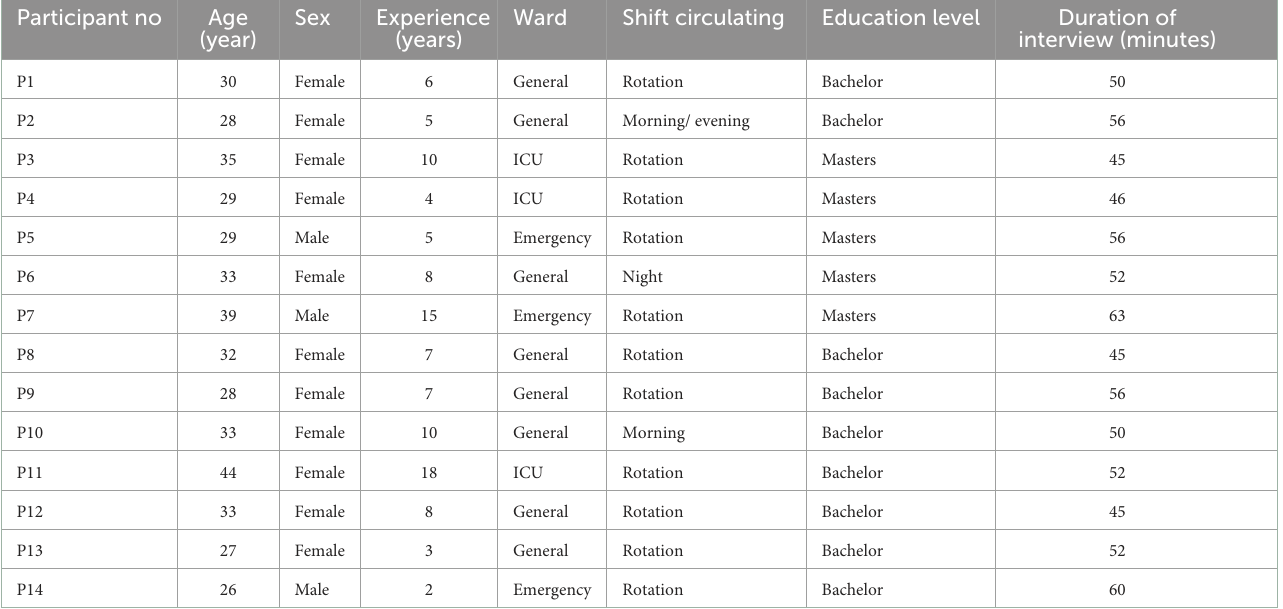
TABLE 1 Demographic and clinical information of study participants.